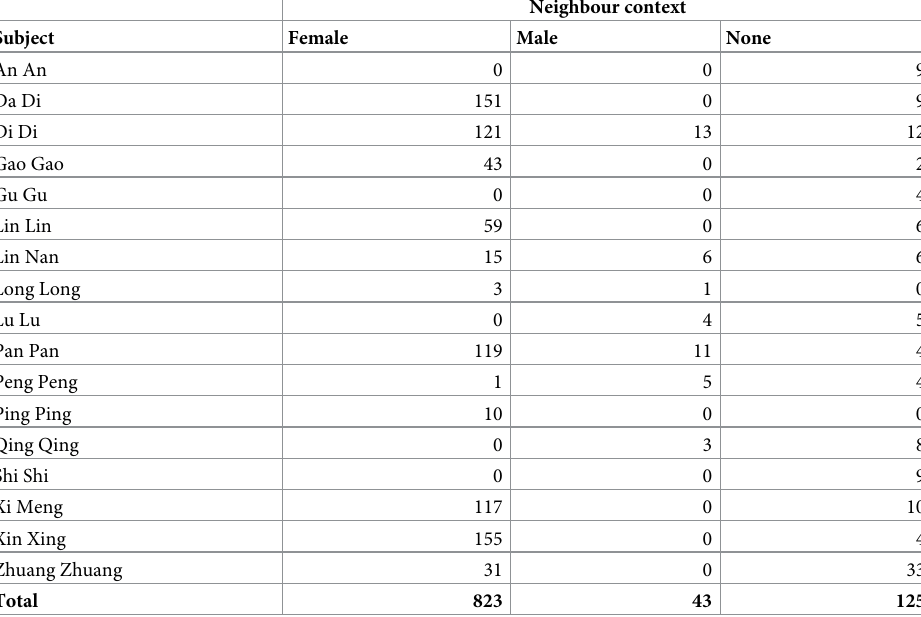
Table 1. The number of 45-minute observation sessions for each subject in the three neighbour contexts. Entering subject identity and observation year as random factors in the GLMMs allowed us to control for the uneven subject participation across neighbour